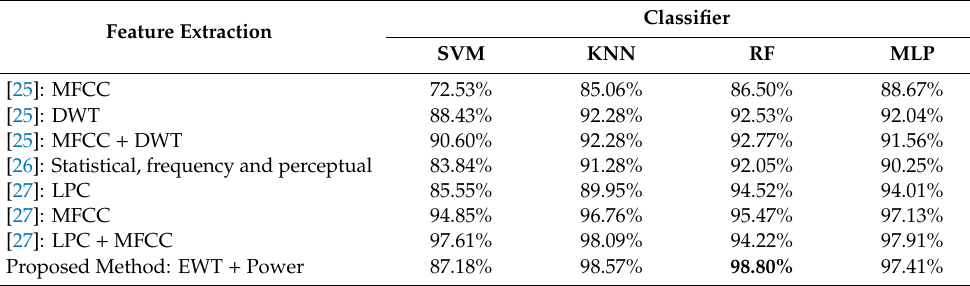
Table 14. Results of sensibility between the methods [25–27] and the proposed.